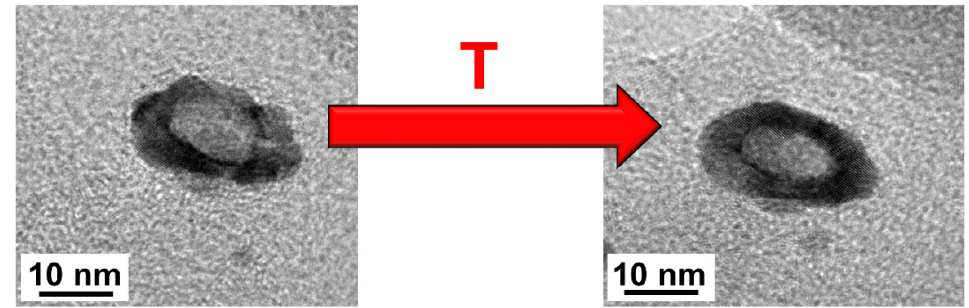
Figure 6. TEM images of PtCu nanoparticle with core–shell structure before and after heating by electron beam.